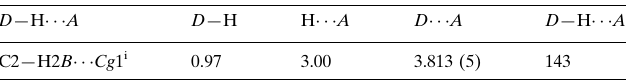
Hydrogen-bond geometry (A˚ , (cid:3) ). Cg 1 is the centroid of the C3–C8